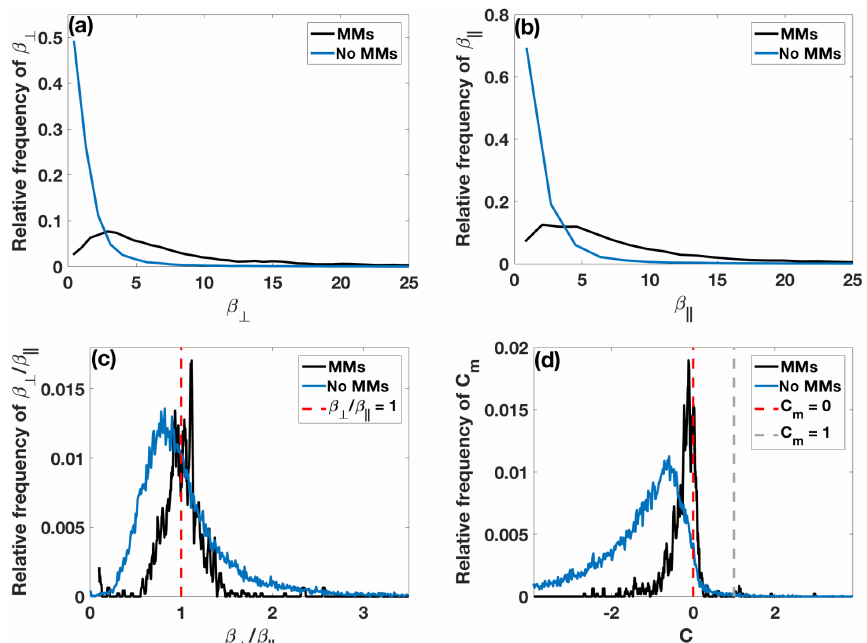
Figure 6. Relative frequency of (a) perpendicular plasma beta ( β ⊥ ), (b) parallel plasma beta ( β (cid:107) ), (c) plasma beta anisotropy ( β ⊥ /β (cid:107) ) and (d) mirror instability threshold ( C m ) values in the surroundings of detected MMs (black curves) and in the parts of the sheath where MMs were not detected (blue curves). In panels (c) and (d) , the red dashed vertical lines show the threshold values for mirror unstable plasma, i.e., β ⊥ /β (cid:107) = 1 and C m = 0. See details from Sect. 1. The grey dashed line in panel (d) marks C m = 1, i.e., the threshold for detecting peak-like MMs. We have checked that the distributions are not biased due to the sheaths containing a large number of MMs.